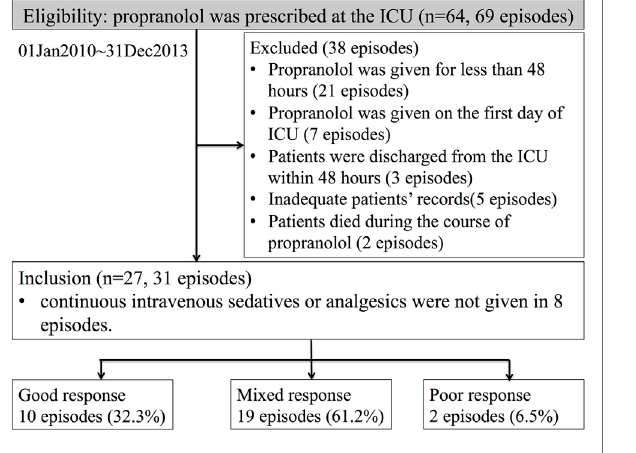
FigUrE 1 | numbers of patients who were eligible, excluded, and analyzed . The definitions of good, mixed, and poor response are explained in the Section “Materials and